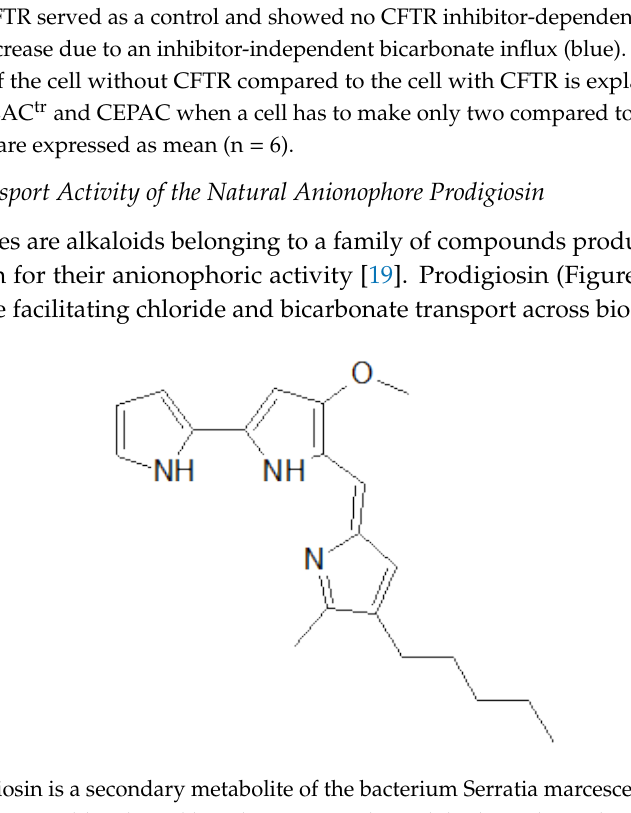
Figure 8. CFTR bicarbonate transport activity. Bicarbonate addition resulted in a CFTR-dependent intracellular increase in cAMP. CFTR inhibition with 10 µM CFTR-specific inhibitor 172 resulted in a reduced cAMP-dependent fluorescence emission ratio increase due to a diminished bicarbonate influx (orange) compared to the control with no CFTR inhibitor present (red). The bicarbonate sensor cell expressing no CFTR served as a control and showed no CFTR inhibitor-dependent di ff erence in cAMP concentration increase due to an inhibitor-independent bicarbonate influx (blue). The higher response to bicarbonate of the cell without CFTR compared to the cell with CFTR is explained most likely by higher levels of sAC tr and CEPAC when a cell has to make only two compared to three proteins upon induction. Data are expressed as mean (n = 6).